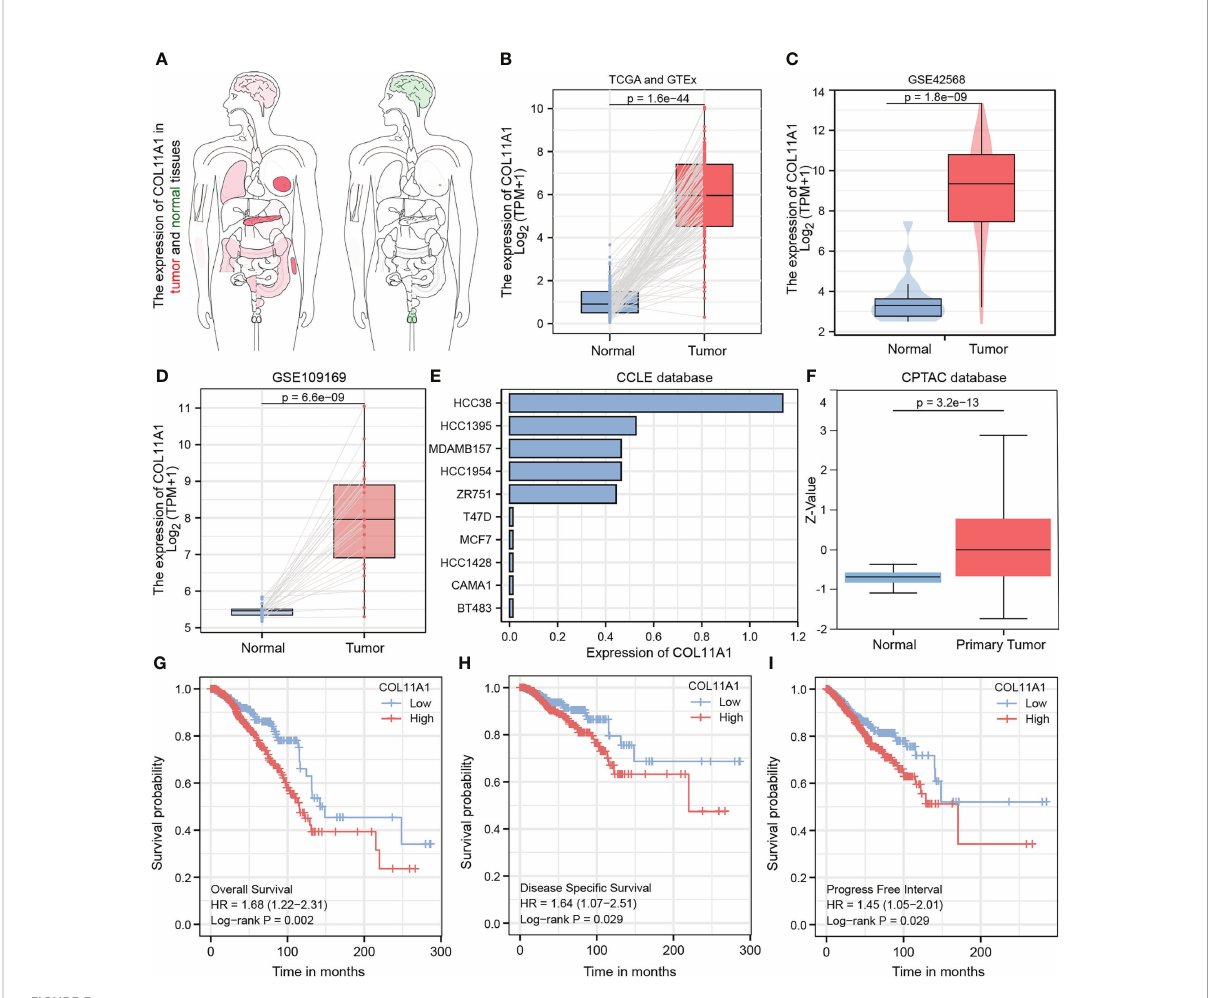
FIGURE 3 Validated expression of hub gene and Analysis prognosis value. Body map (A) , TCGA and GTEx (B) , GSE42568 (C) and GSE109169 (D) con fi rmed that COL11A1 high expression in tumor tissues.COL11A1 could be highly expressed in HCC38, HCC1395, MDAMB157, HCC1954, and ZR751 cell lines and low expressed in T47D, MCF7, HCC1428, CAMA1, and BT483 cell lines (E) . COL11A1 was a high expression in tumor samples (F) . COL11A1 was associated with poor prognosis of patients, either Overall Survival, Disease-Speci fi c Survival, or Progress Free Interval (G – I)